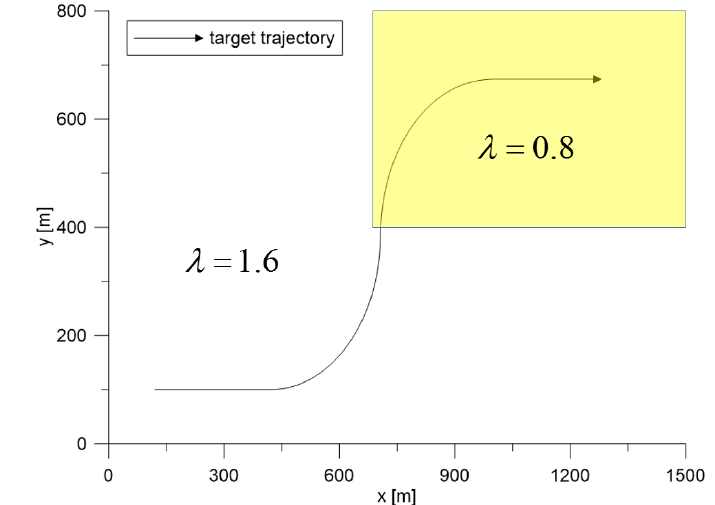
Figure 15. The maneuvering target trajectory in the surveillance